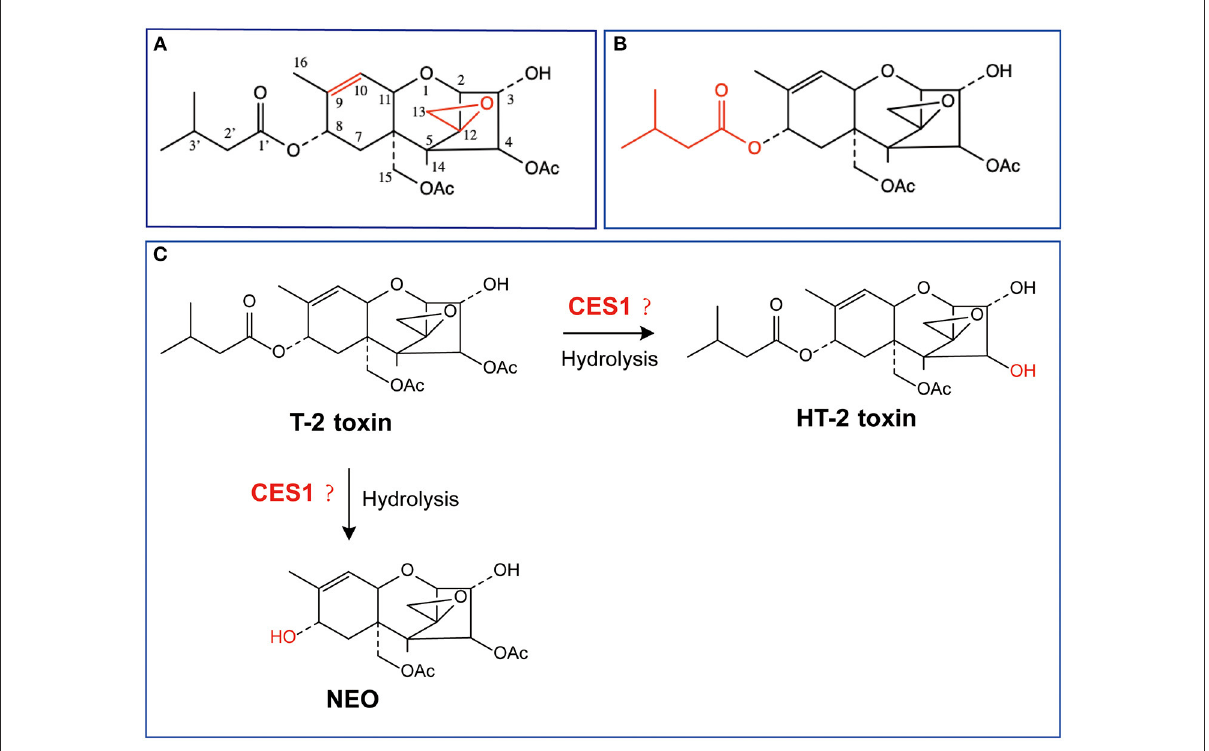
FIGURE1 Chemical structures of T-2 toxin and its putative hydrolytic metabolic pathways. (A) Toxic group; (B) Acetyl group; (C) Possible hydrolytic metabolic pathways. NEO, neosolaniol.